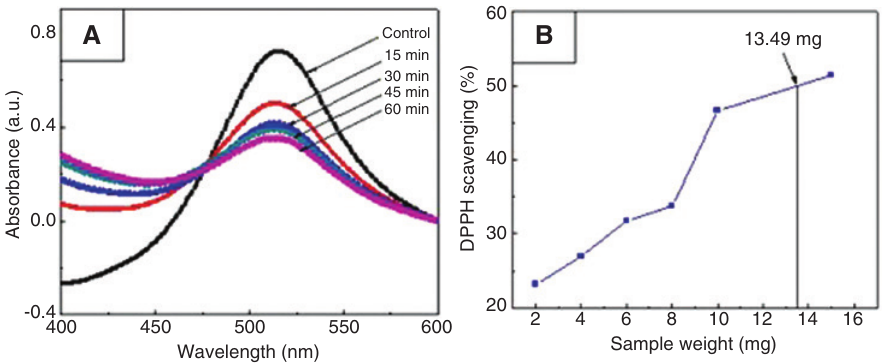
Figure 4: Antioxidant activity. (A) Time dependent diphenyl-1-picrylhydrazyl (DPPH) scavenging and (B) DPPH scavenging (%) at different weights of nanocomposite.